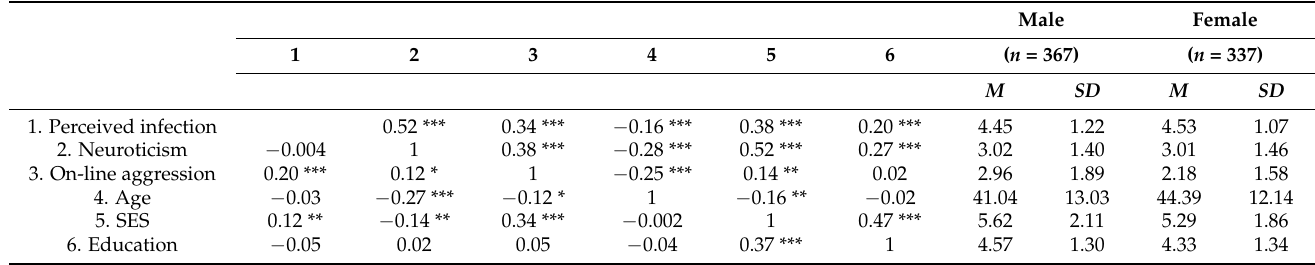
Table 1. Descriptive statistics and correlations among variables.